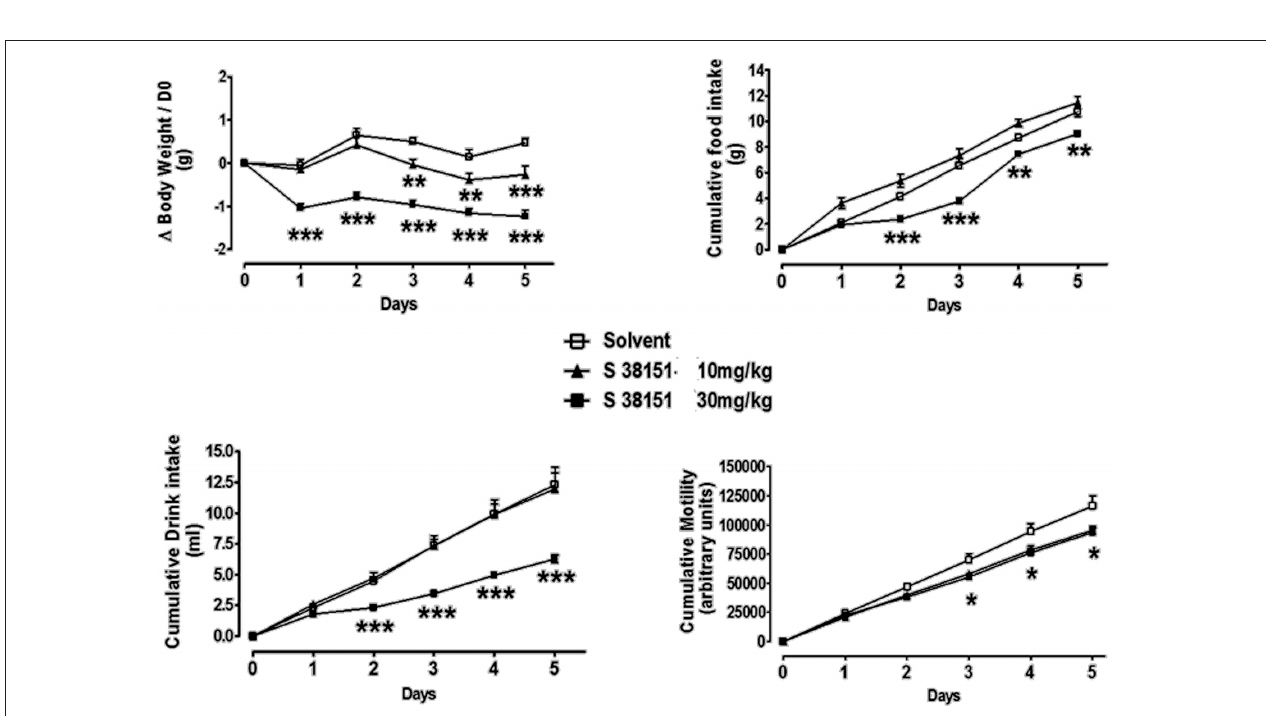
squares for controls, dark squares for 10mg/kg, and dark triangles for 30mg/kg. Repeated measures Two-Way ANOVA (treatment × time) was followed by complementary analysis of each treatment’s effect at a fixed level of time to compare all groups of mice with the control group. * P < 0 . 05.